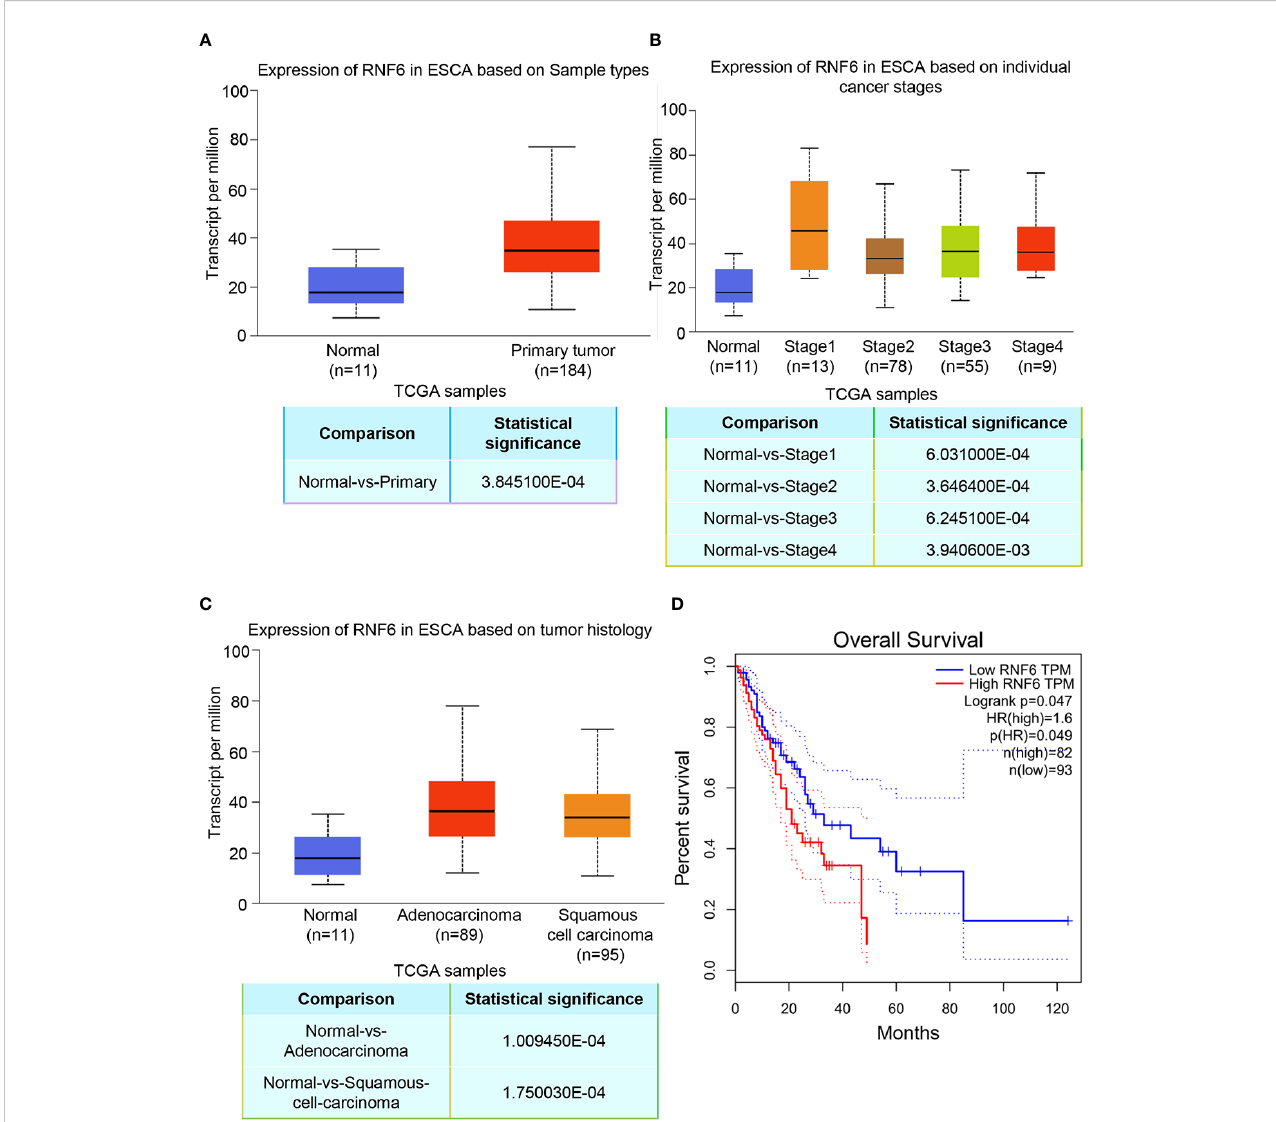
FIGURE 1 Upregulation of RNF6 expression promotes esophageal cancer progression and predicts poor prognosis. (A) TCGA analysis of the relative levels of RNF6 in adjacent normal tissues and esophageal cancer tissues. (B) Relative expression of RNF6 in esophageal cancer stage I, II, III/IV tissues. (C) RNF6 levels in ESCA of different pathological types. (D) The OS of 175 cases of esophageal cancer was analyzed by Kaplan-Meier, and the log-rank test was performed according to the RNF6